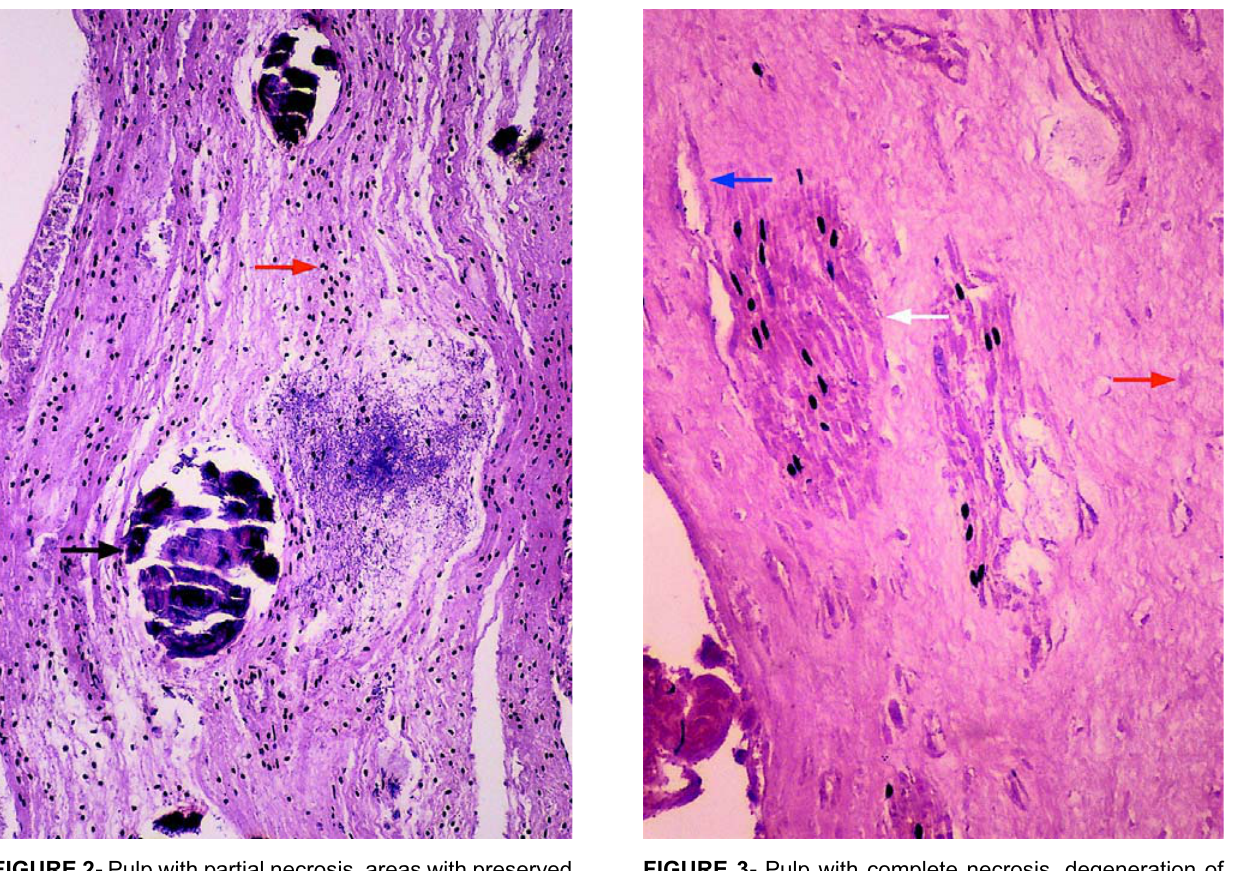
FIGURE 2- Pulp with partial necrosis, areas with preserved cell nuclei (red arrow) and calcification (black arrow) TABLE 3- Analysis of clinical criteria employed for the diagnosis of pulp necrosis